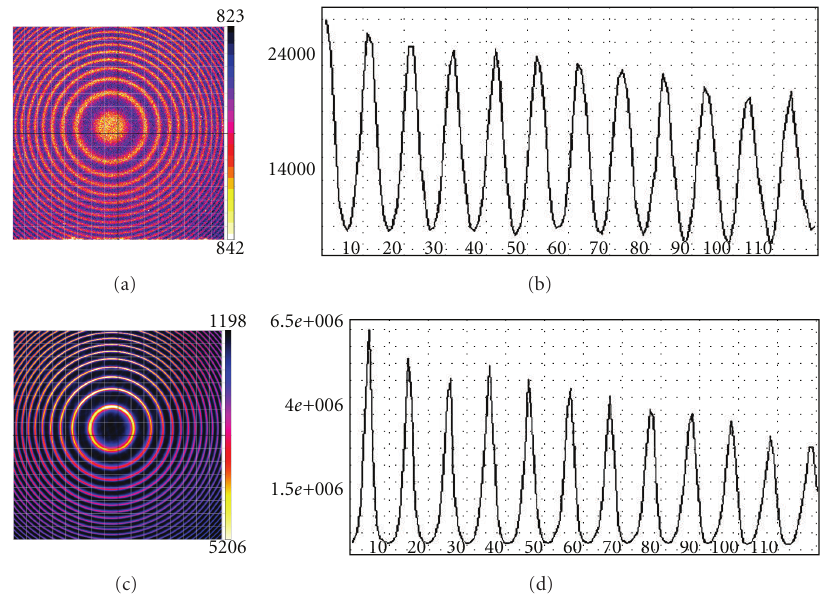
Figure 2: Images ((a) and (c)) and interferograms ((b) and (d)) for 630 nm sky and HeNe laser observations made by the PARI FPI instrument. The interferograms are calculated by annular integration around the ring center of the circular pattern in each image. 500 channels of equal areas are used to generate the